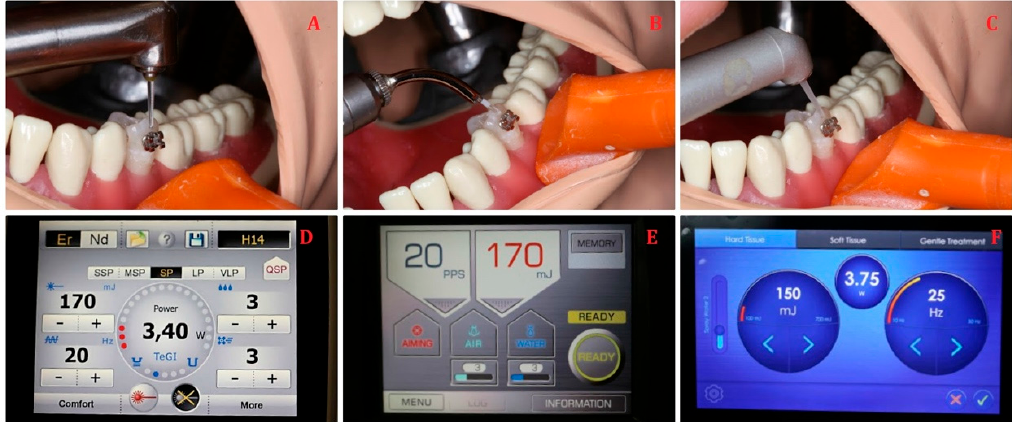
Figure 5. Orthodontic brackets debonding with Er:YAG lasers: ( A , D ) LightWalker; ( B , E ) AdvErL Evo; ( C , F ) LiteTouch.